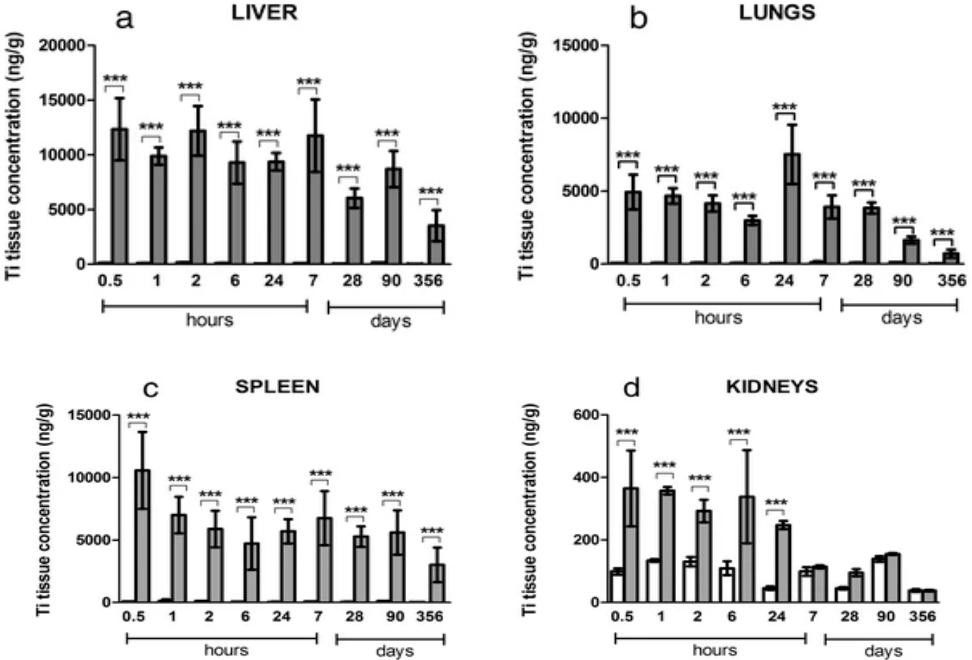
Figure 33. Biopersistence of titanium level in ( a ) liver, ( b ) lungs, ( c ) spleen and ( d ) kidneys after intravenous injection of 1 mg / kg TiO 2 NPs in rats for 365 days. Grey and white bars are treated and control mice, respectively. Error bars represent the mean ± SD and n = 6. Statistical comparison is performed by two-way ANOVA, * p < 0.05; ** p < 0.01; *** p < 0.001. Reproduced with permission from [333]. Copyright BioMed Central, 2015.